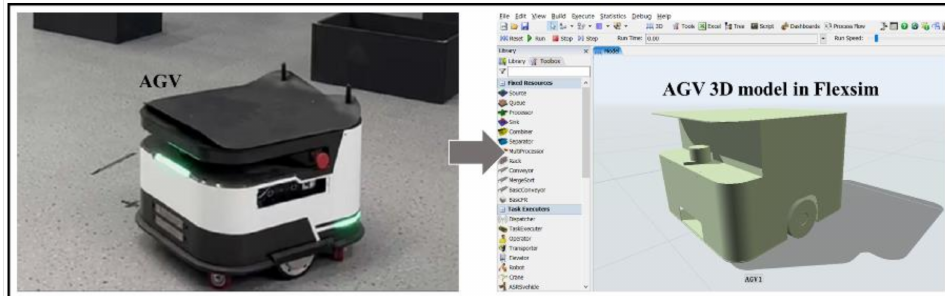
Figure 8. AGV 3D model imported into Flexsim.